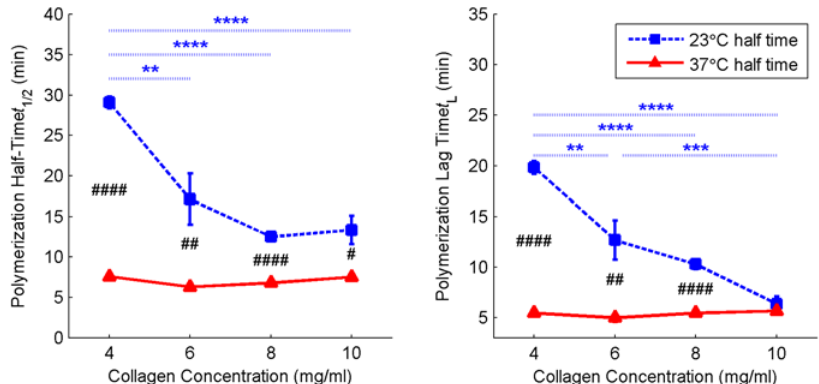
Fig 4. Kinetics of collagen hydrogel polymerization. Blue square symbols with dashed lines represent hydrogels polymerized at 23°C while red triangle symbols with solid lines represent hydrogels polymerized at 37°C. As the effect of pH was statistically non-significant (p > 0.05), data is averaged over all three pH groups. Data shown are mean + SE with N = 6 – 12. Significance was calculated for pH-averaged groups: temperature means comparison is indicated with # while concentration means comparison is indicated with * . At 37°C (solid red lines), concentration had no significant effect on either polymerization half-time or polymerization lag